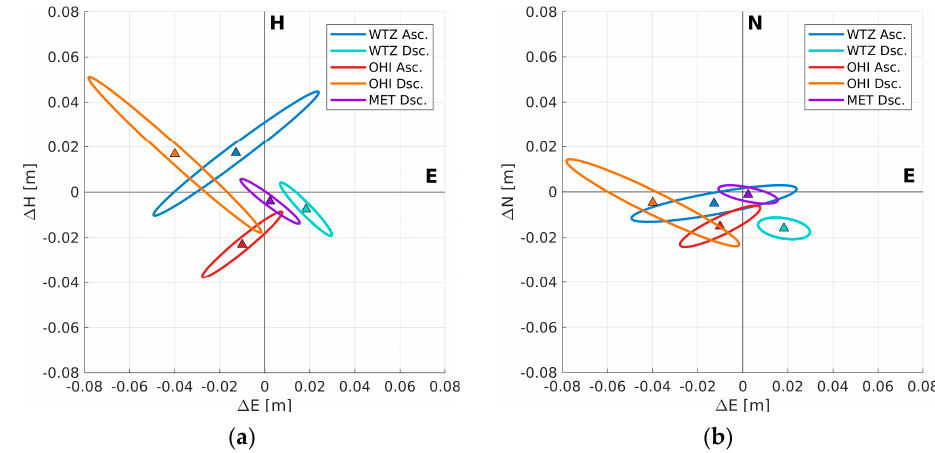
Figure 9. Differences of the TerraSAR-X stereo coordinates to the reference coordinates, and the error ellipsoid of the SAR solution scaled to 95% confidence level: Horizontal cross section in local east/height ( a ); vertical cross section in local north/east ( b ). WTZ = Wettzell, OHI = GARS O’Higgins and MET = Metsähovi.